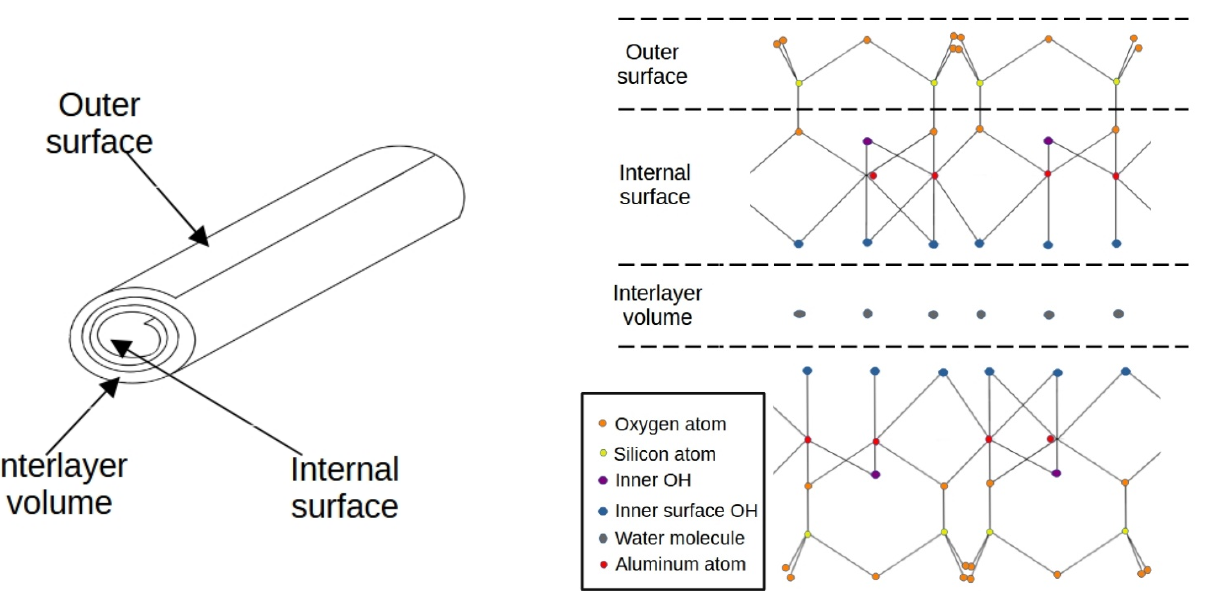
Figure 1. Halloysite structural scheme.